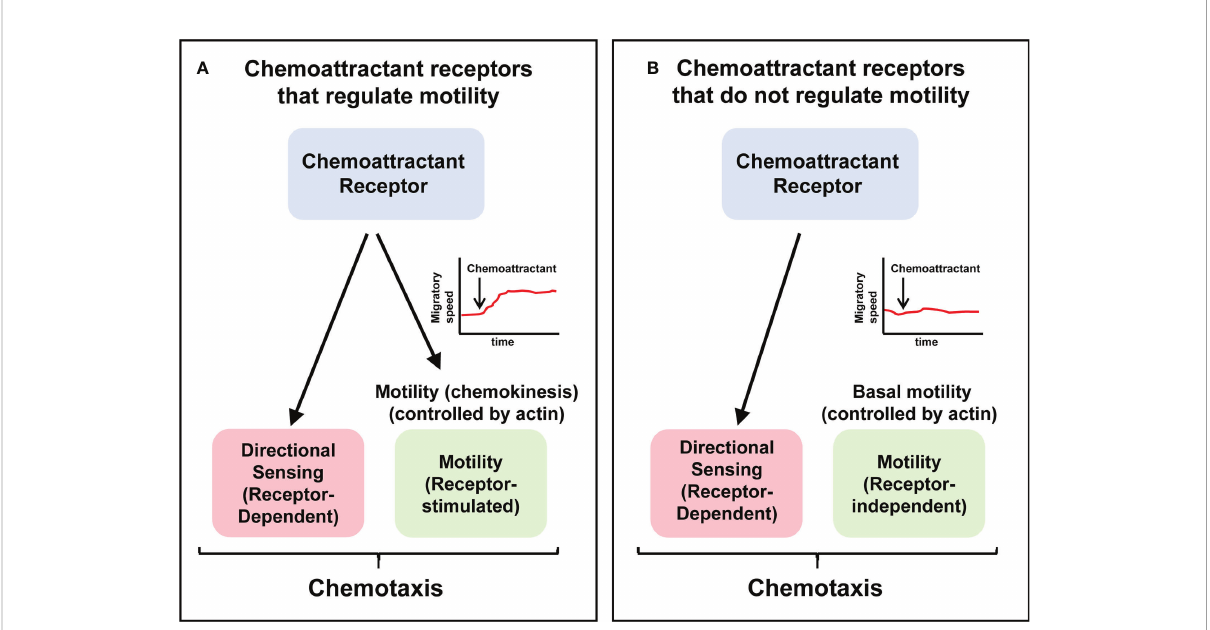
FIGURE 2 The ability to control chemokinesis is not an obligatory activity of chemoattractant receptors Chemotaxis involves directional sensing and motility. Chemoattractant receptors can be functionally classi fi ed into two groups. (A) Receptors that control both directional sensing and motility (chemokinesis). (B) Receptors that control directional sensing, but not chemokinesis, implying that stimulation of these receptors do not alter the speed of the cells. Current models of chemoattractant receptors-mediated signaling are largely based on the receptors shown in (A) See Tables 1, 2, for examples of both types of